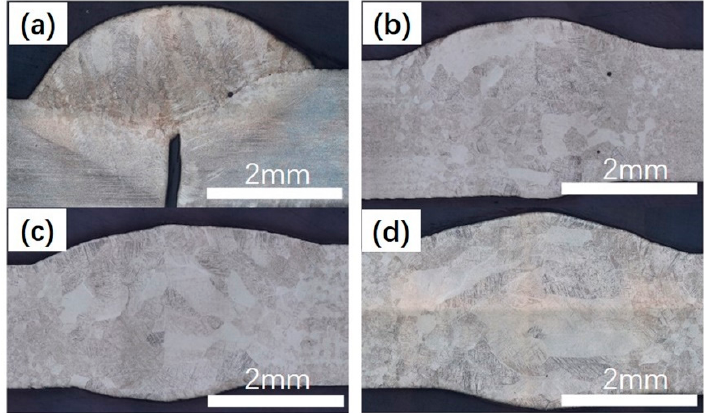
Figure 12. The cross section of welded joints at different laser powers; ( a ) 2.5 kW; ( b ) 3 kW; ( c ) 3.5 kW; ( d ) 4 kW.